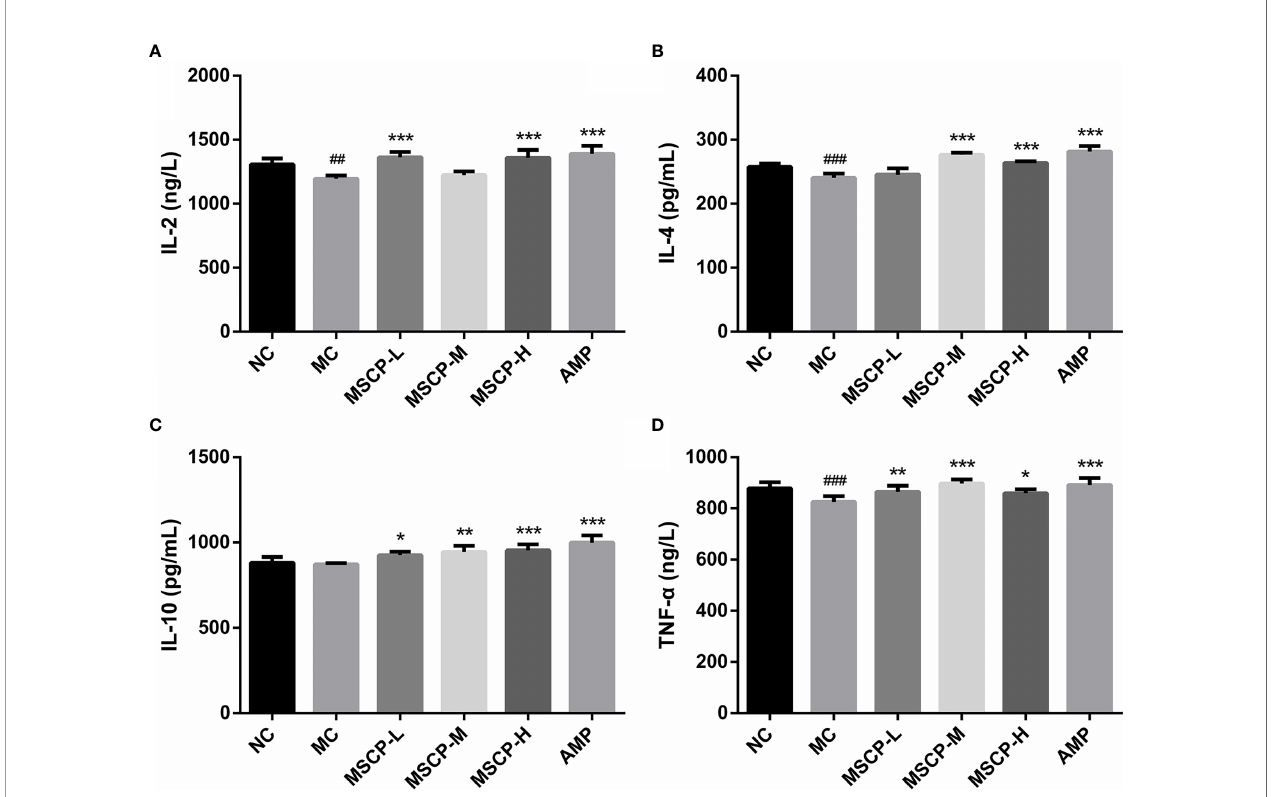
FIGURE 5 | Effects of MSCP on the levels of cytokines in intestine of mice. (A) IL-2; (B) IL-4; (C) IL-10; and (D) TNF- a . Data are expressed as mean ± SD. ## p < 0.01, ### p < 0.001 compared with NC group; * p < 0.05, ** p < 0.01, *** p < 0.001 compared with MC